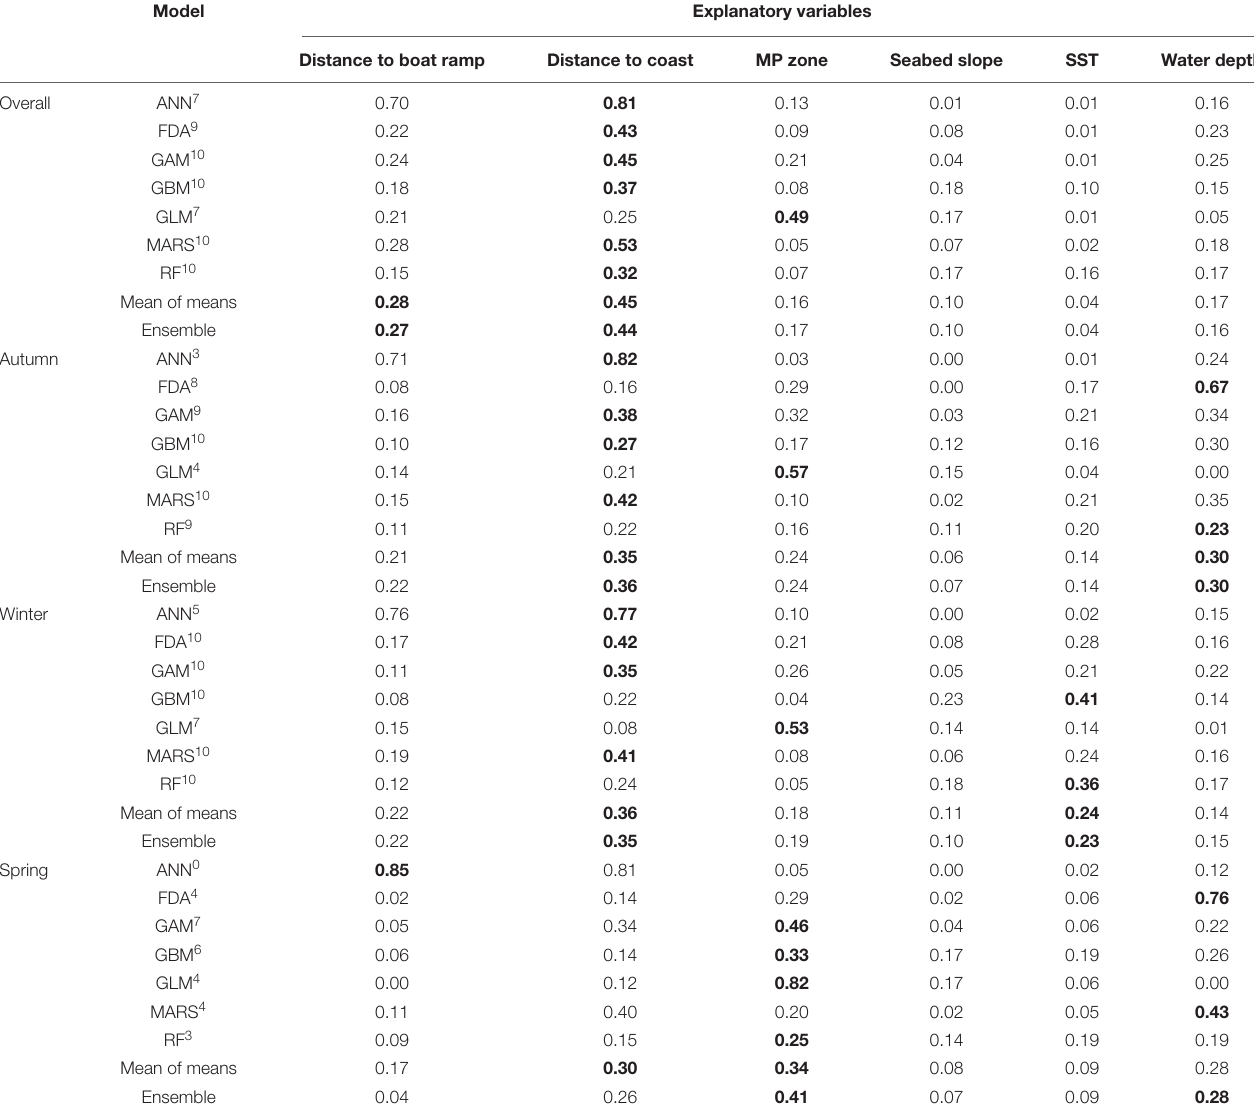
TABLE 3 | Importance of predictor variables used in the overall and seasonal species distribution models (SDMs) of Indo-Pacific bottlenose dolphins ( Tursiops aduncus ) at the North West Cape (NWC), Western Australia (WA).